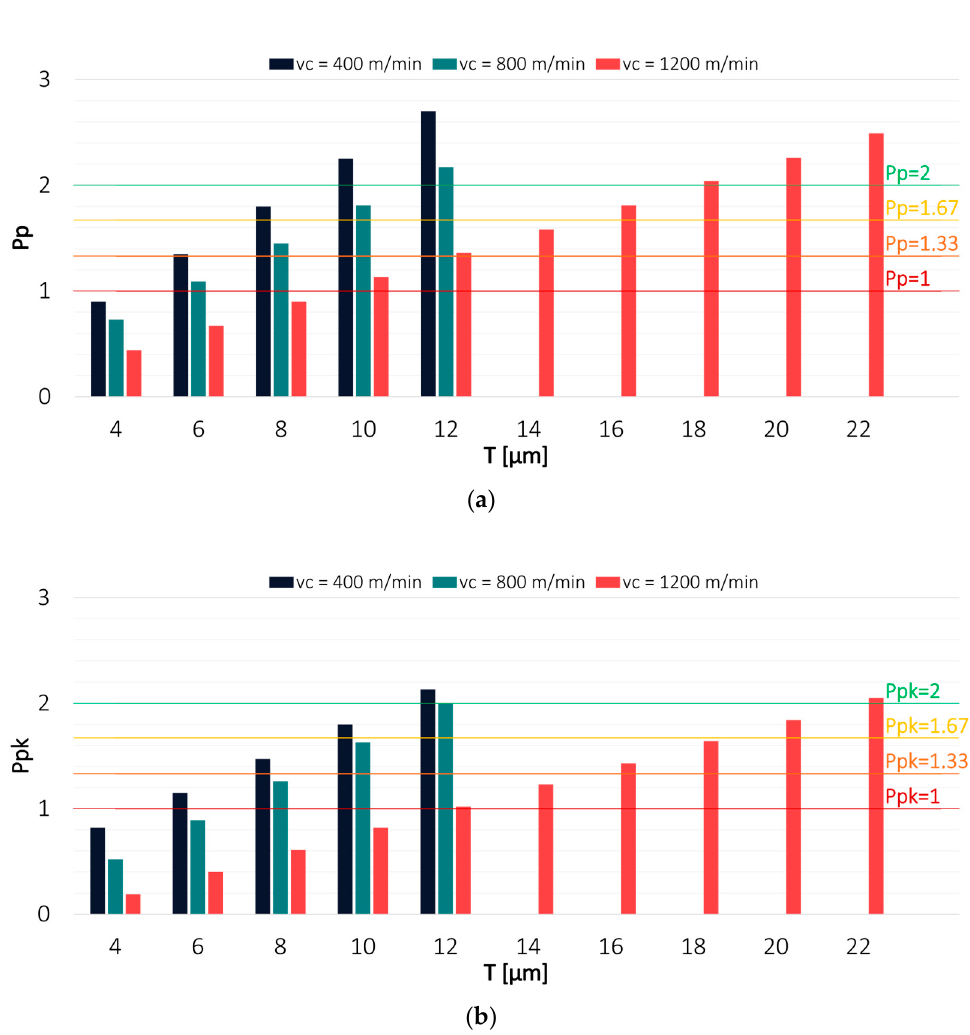
Figure 5. Values of ( a ) Pp and ( b ) Ppk for the results obtained in a milling process conducted with variable cutting speed and TiB2-coated tool.